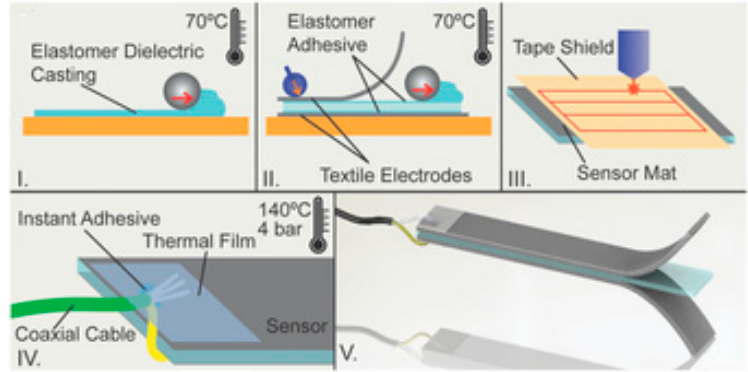
Figure 9. Schematic diagram of the manufacturing procedure of the composite textile-silicone sensor: ( i ) Dielectric silicon casting, ( ii ) connecting fabric electrodes using silicone elastomer casting, ( iii ) attaching tape shield and laser cutting of sensor, ( iv ) formation of a permanent electrical connection between coaxial cable and fabric electrode using adhesive and thermal film, and ( v ) 3D-representation of the sensor. Reproduced from Atalay, A., Sanchez, V., Atalay, O., Vogt, D.M., Haufe, F., Wood, R.J. and Walsh, C.J., 2017. Batch fabrication of customizable silicone-textile composite capacitive strain